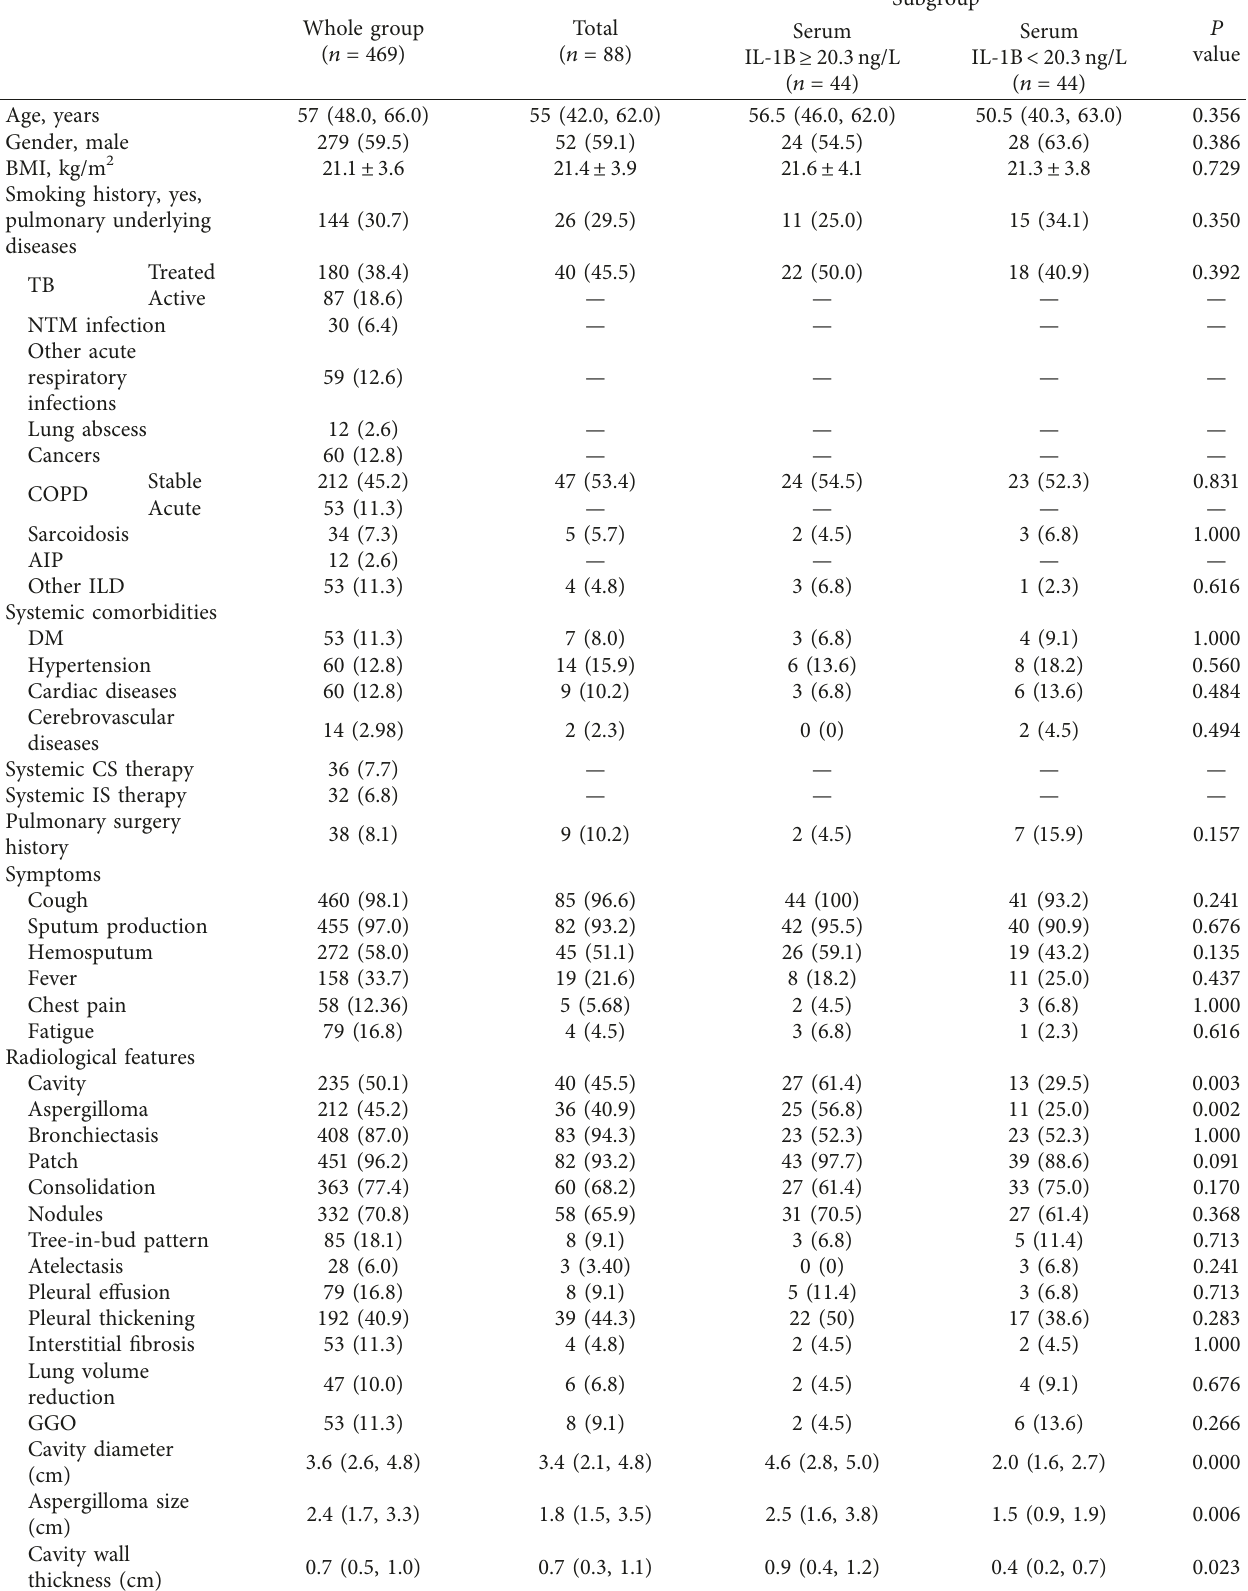
Table 1: Clinical characteristics of subjects with CPA in the whole and subgroup